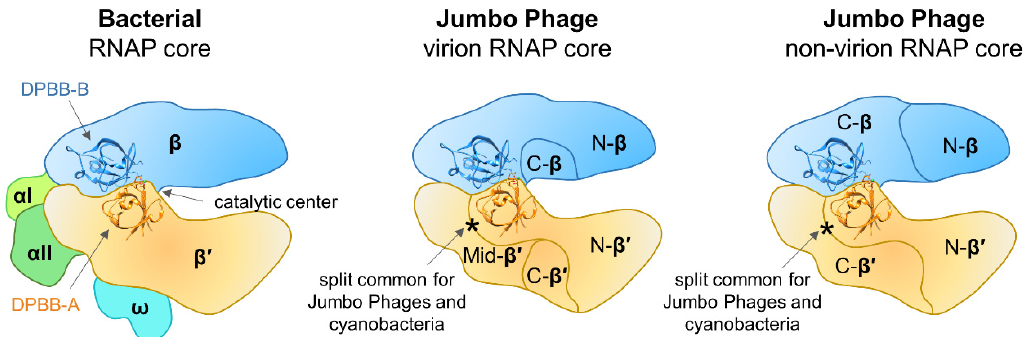
Figure 3. Schematic representation of bacterial and jumbo phage RNAP core enzymes. Structures of DPBB domains are taken from the T. thermophilus RNAP crystal structure (PDB: 2O5J) [11]. Jumbo phage RNAPs do not contain homologs of bacterial RNAP α and ω subunits. The virion RNAP (vRNAP) core is composed of at least five polypeptides: N- β′ , Mid- β′ , C- β′ , and N- β , C- β , homologous to the N-terminal, middle, and C-terminal parts of bacterial β′ , and N-terminal and C-terminal parts of bacterial β , correspondingly. The non-virion RNAP (nvRNAP) core is composed of four polypeptides: N- β′ , C- β′ , and N- β , C- β , homologous to the N-terminal and C-terminal parts of β′ , and N-terminal and C-terminal parts of β , correspondingly. The DPBB-A is present in the N-terminal parts of β′ in both vRNAP and nvRNAP. The split site after DPBB-A (marked by asterisk) is common for vRNAP, nvRNAP, and cyanobacterial RNAP.